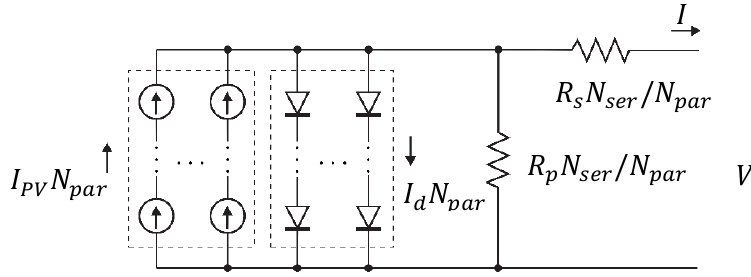
Figure 3. Equivalent circuit of an array consists of modules connected in a parallel-series fashion.